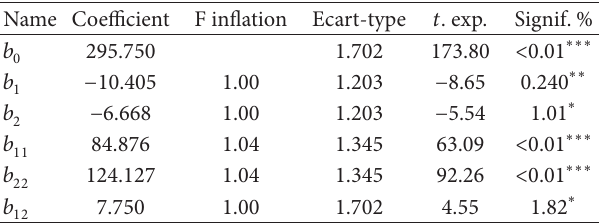
T 7: Analysis of variance of methylene blue adsorption, MB/AC-H